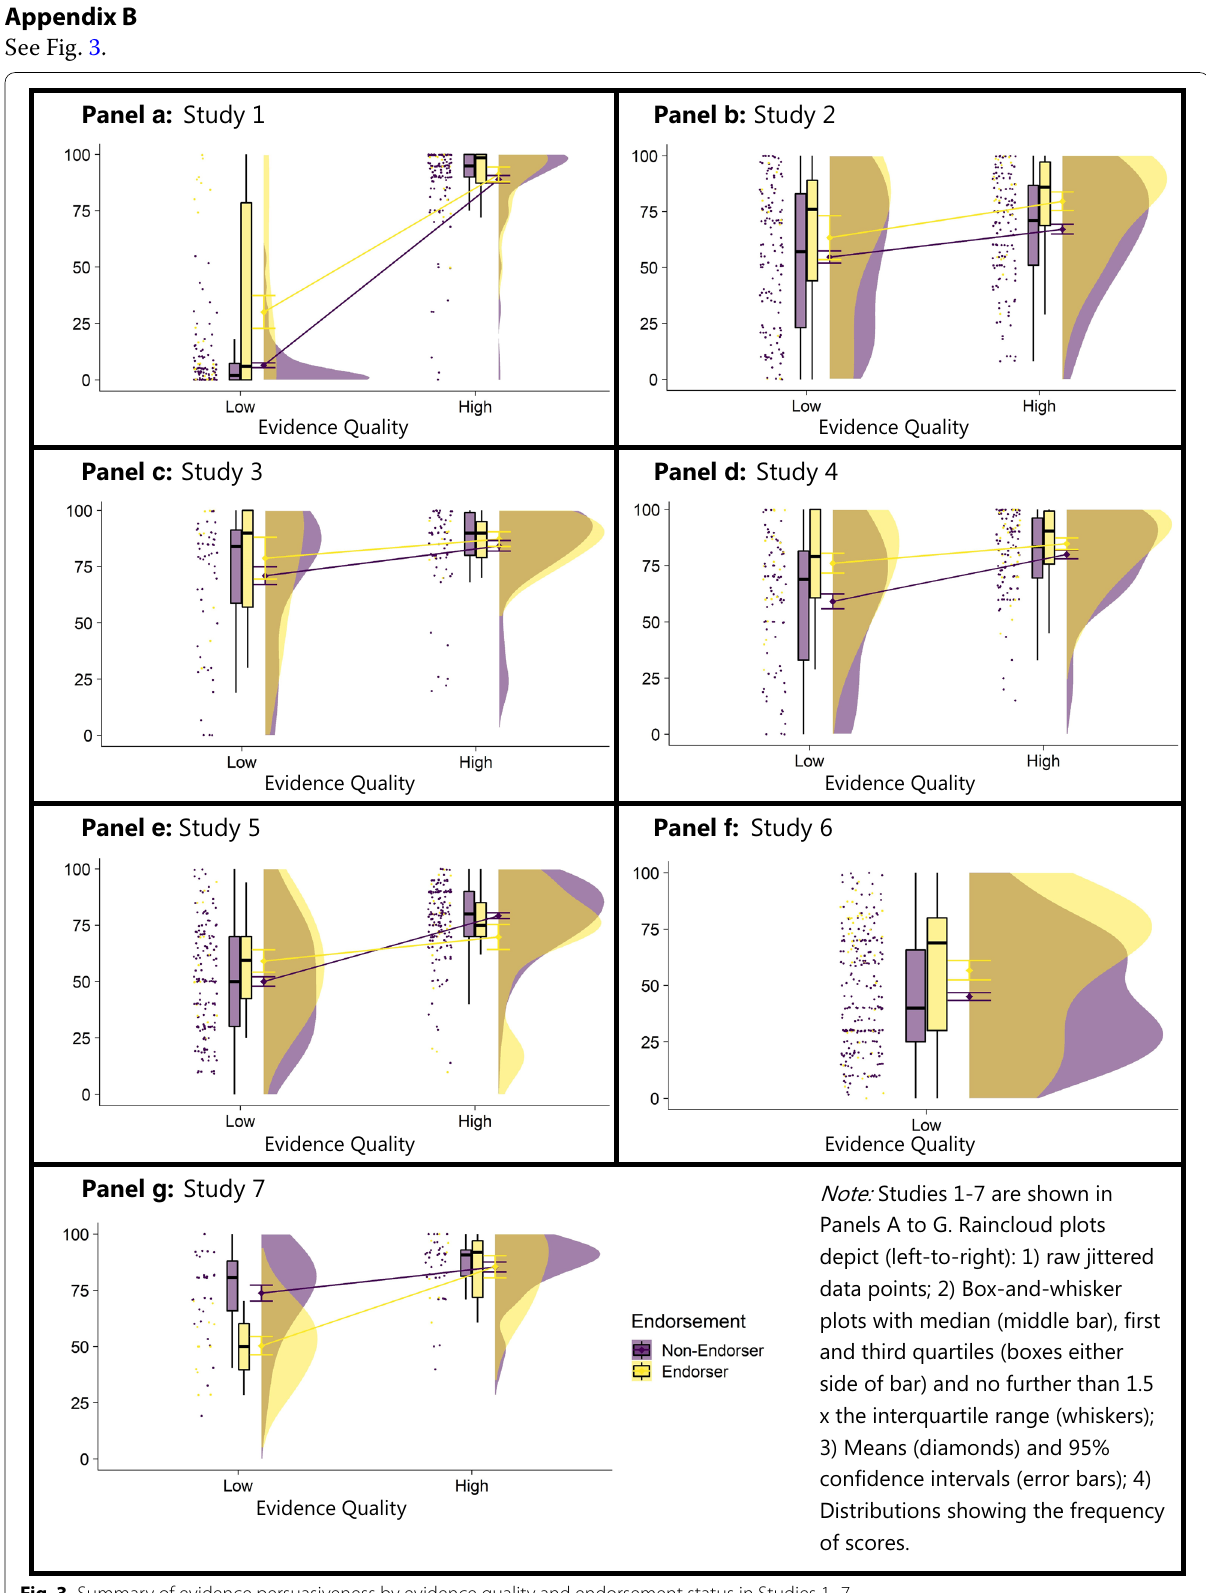
Fig. 3 Summary of evidence persuasiveness by evidence quality and endorsement status in Studies